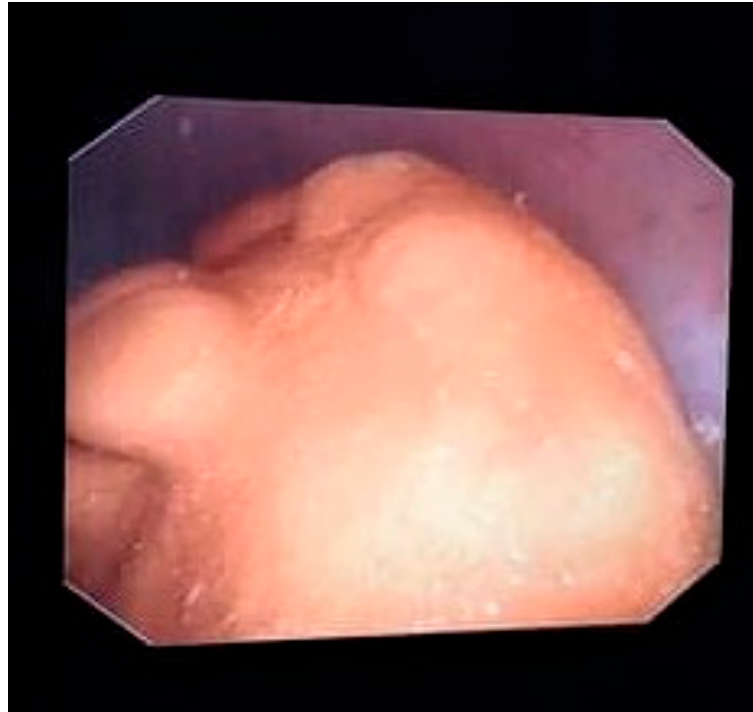
Figure 2. Endoscopy image of the stone.